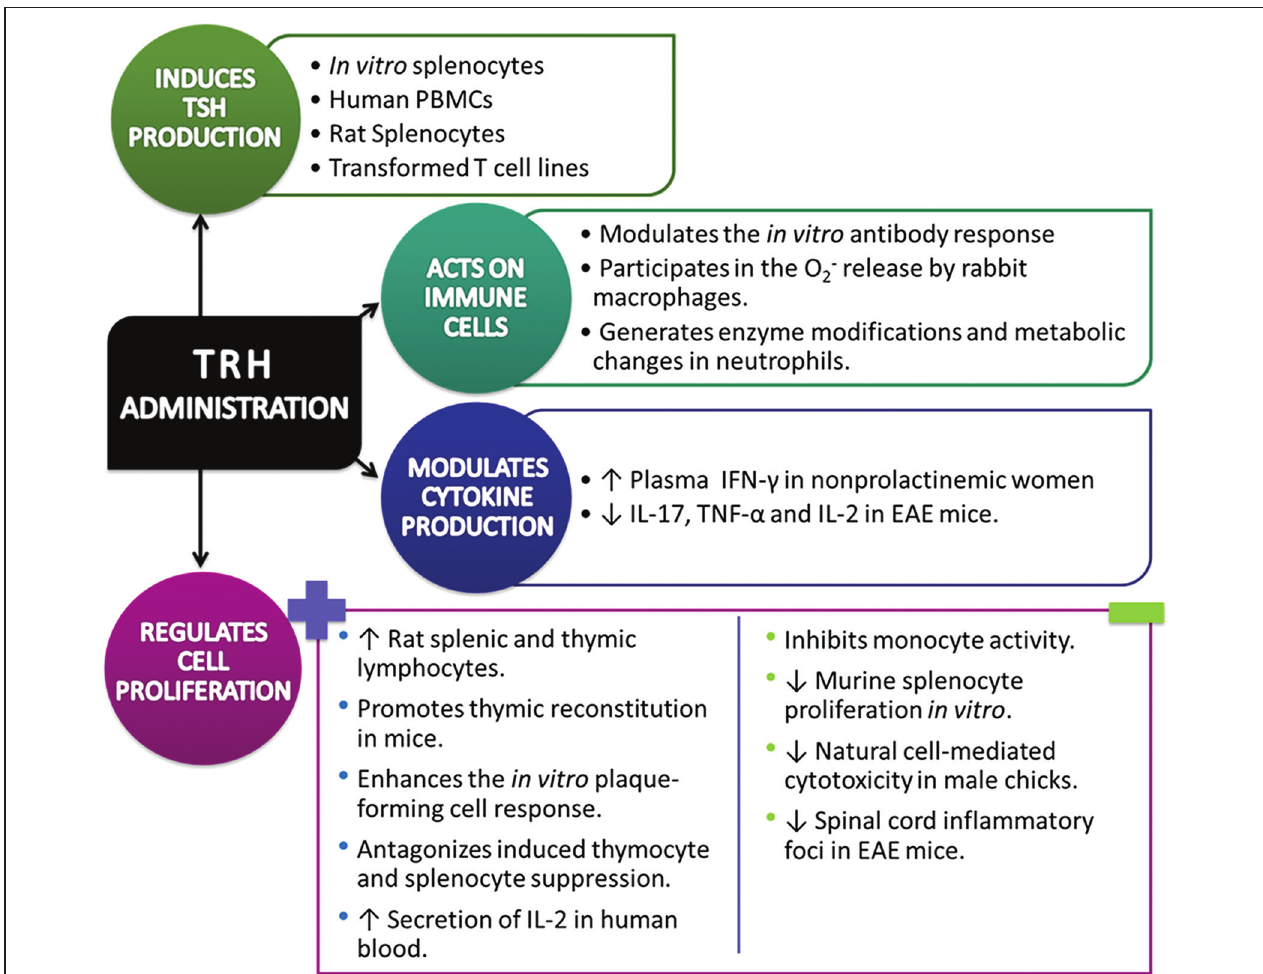
FIGURE 1 | Immune response against Thyrotropin-ReleasingHormone/Thyrotropin-ReleasingHormone agonist administration in a diversity of normal and pathological conditions ( ↑ = increase, ↓ =